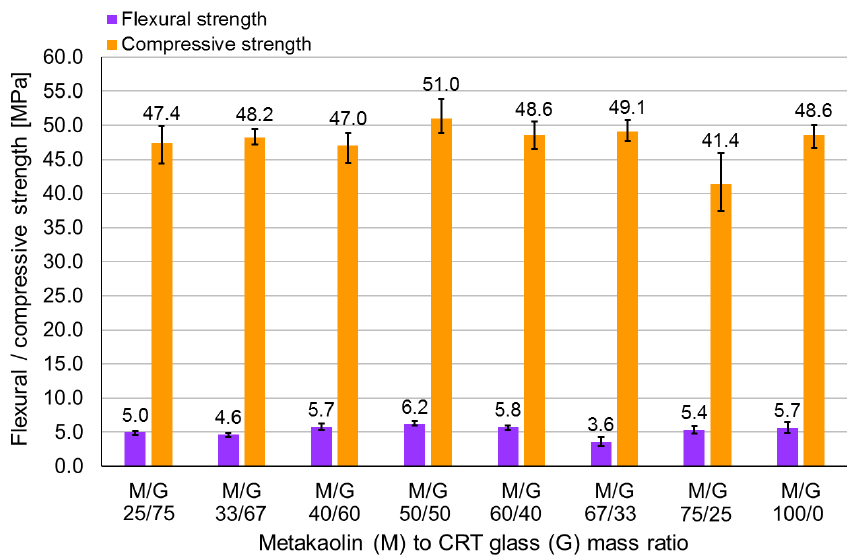
Figure 3. Compressive and flexural strength of geopolymer samples with varying metakaolin-to- CRT-glass ratios.